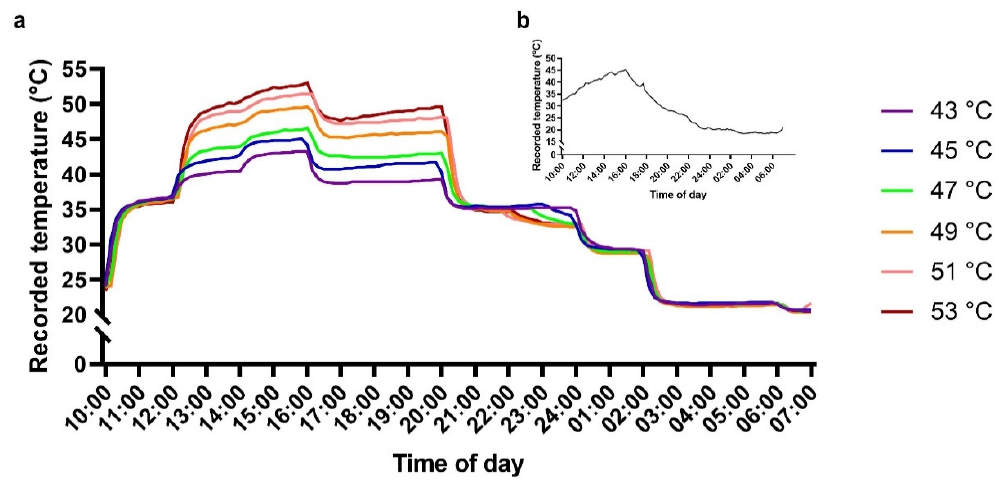
Figure 1. Artificial and natural temperature gradients. ( a ) Avocado plants were subjected to the different stepped temper- ature gradients recorded in the controlled-climate chamber. ( b ) Recorded temperatures of an actual extreme heat event that occurred in July 2020 in an avocado orchard located in northern Israel .